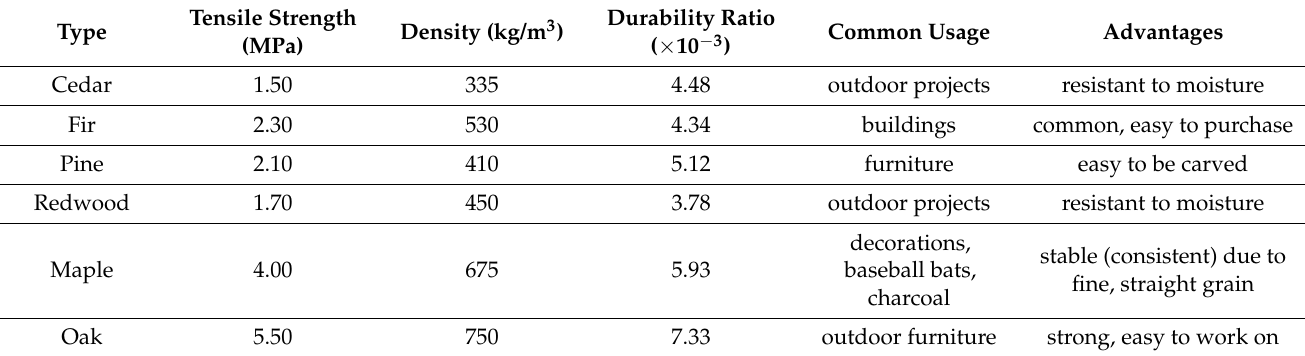
Table 5. Comparison of common types of wood.